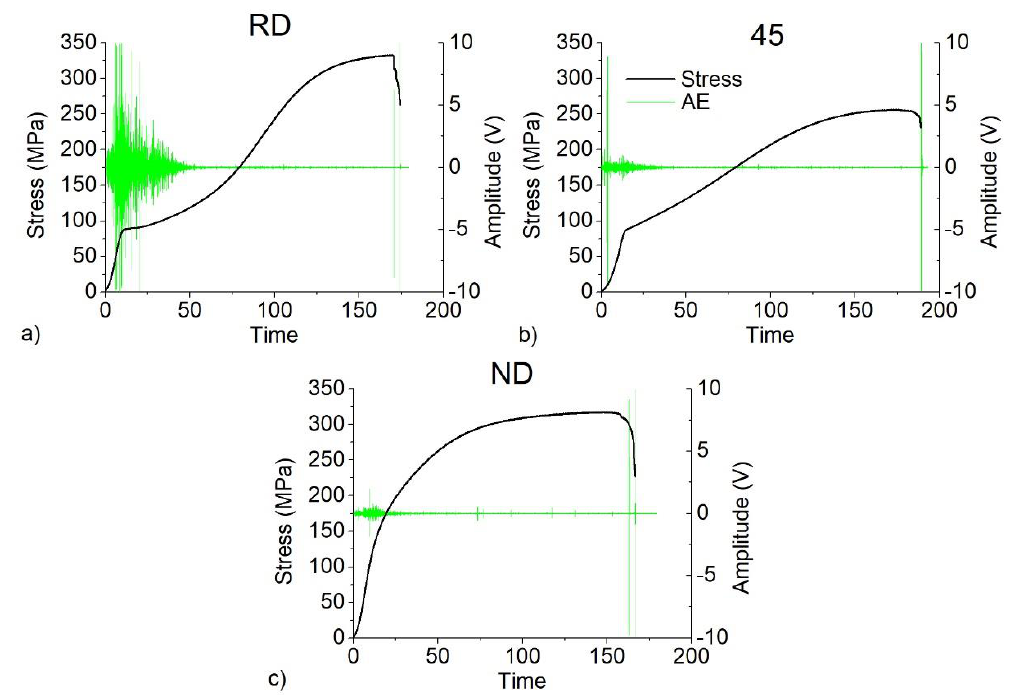
Figure 4. The deformation curves of the samples ( a ) RD, ( b ) 45, and ( c ) ND and the concurrently recorded raw AE signals.